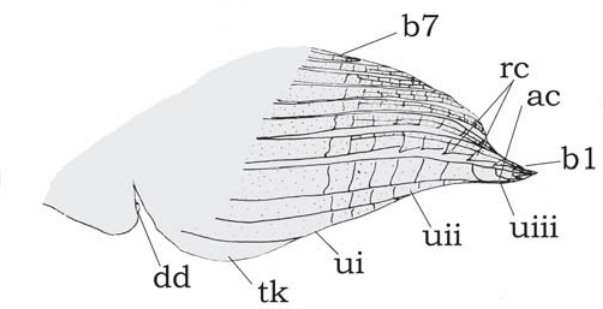
Fig. 15. Male modified anal fin of Tatia brunnea , RMNH 26196, holotype, 56.5 mm SL. Left side lateral view. Abbrevia- tions: ac , antrorsely curved denticulation; b1 , branched first ray; b7 , branched seventh ray; dd , deferent duct; rc , retrorsely curved denticulation; tk , tegumentary keel; ui , unbranched first ray; uii , unbranched second ray; uiii , unbranched third ray. Scale bar =1.0